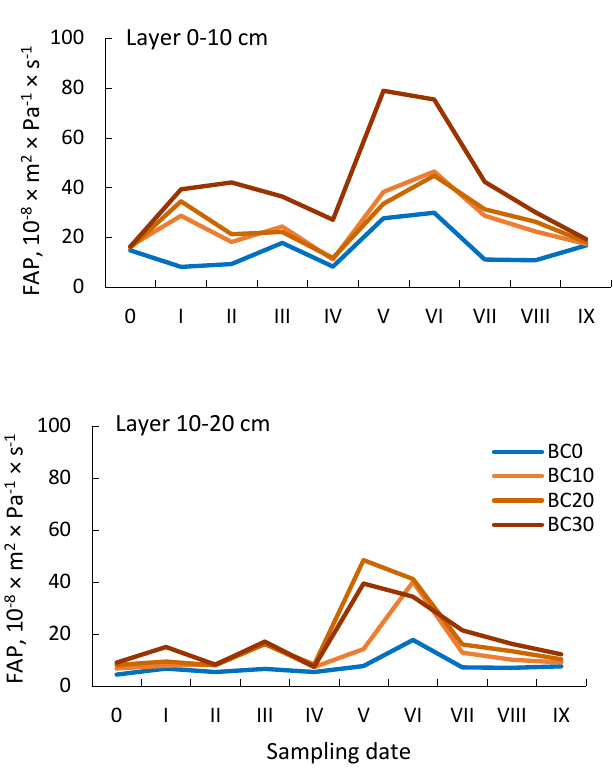
Figure 5. Air permeability at the potential −15.5 kPa (FAP). Explanations as for Figure 1.